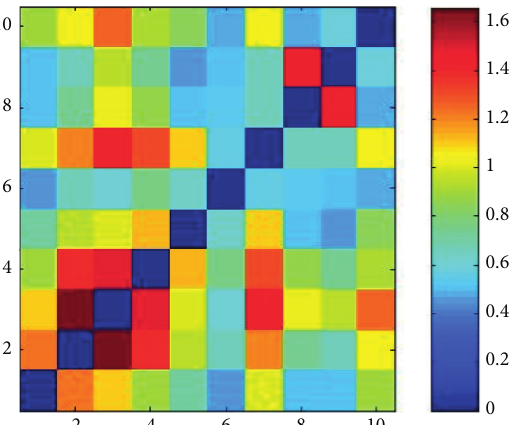
Figure 2: Colormap of industry sector indexes network in the pandemic period (the numbers on the horizontal and vertical axes represent the 10 sector indexes in Table